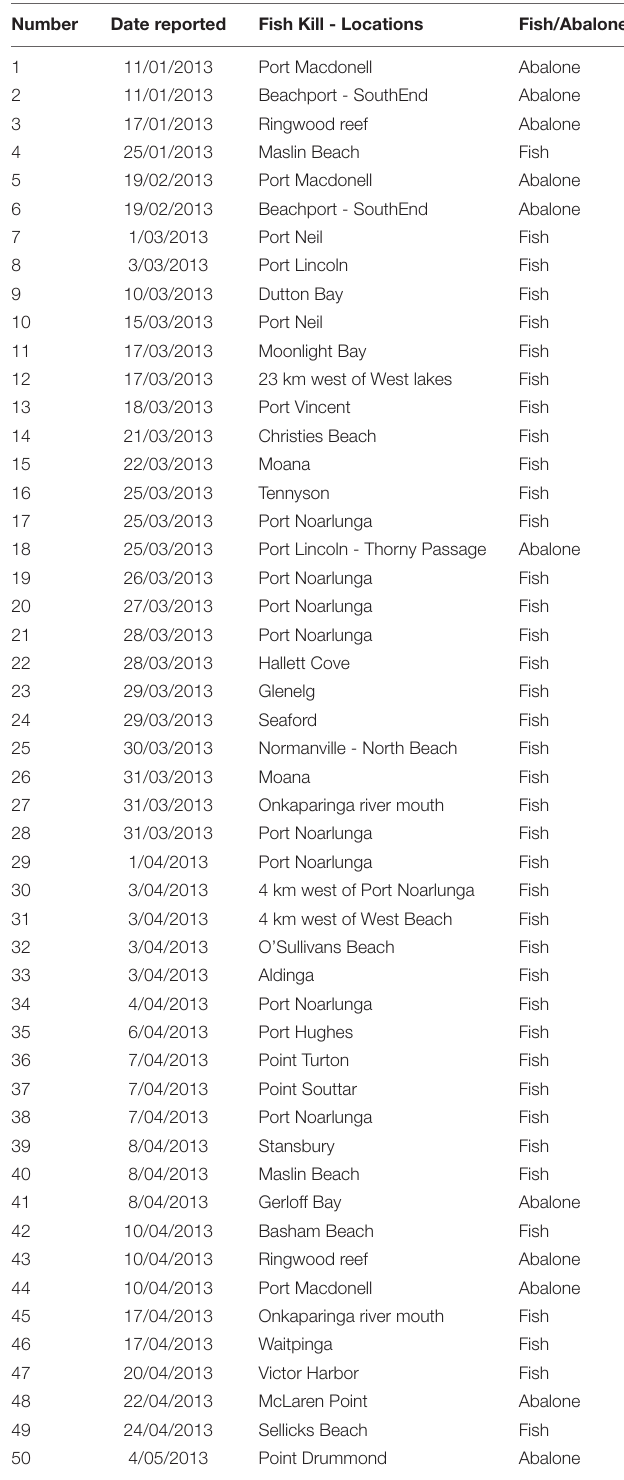
TABLE 1 | Number, date and locations of reported fish and abalone